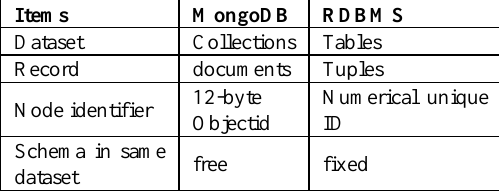
Table 1. Comparison between MongoDB and RDBMS